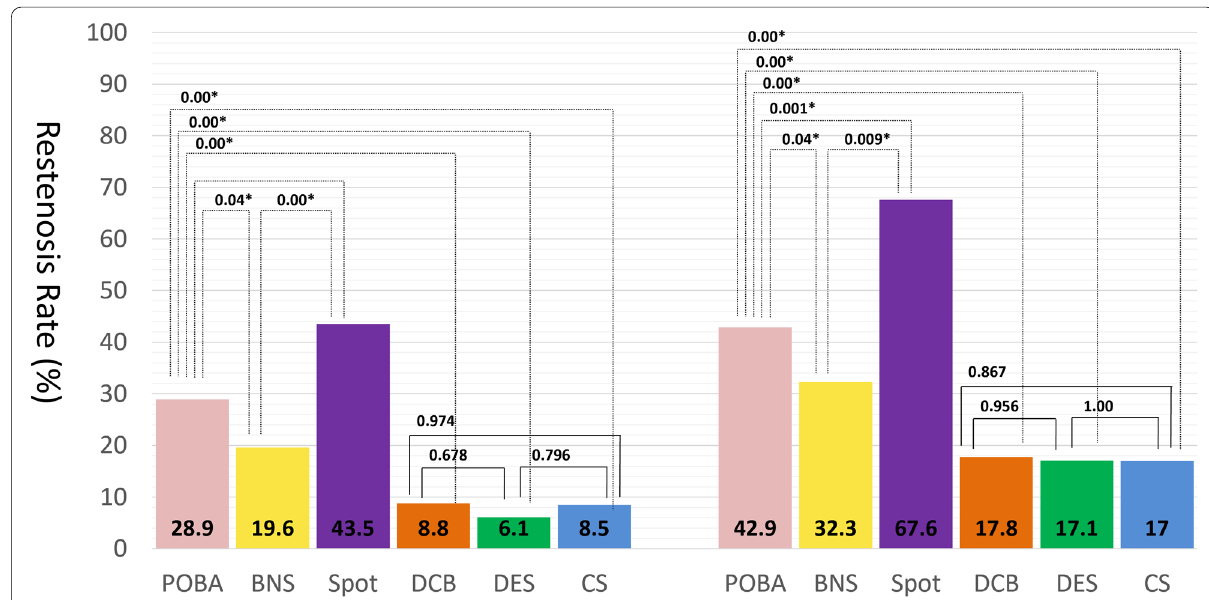
Fig. 4 The restenosis rate of six months and one year by the strategy. The low restenosis rate was proven in DCB, DES, and CS groups. Otherwise, the restenosis rates in the POBA, BNS, and spot stent strategy groups were significantly higher. BNS: bare nitinol stent, CS: covered stent, DCB: